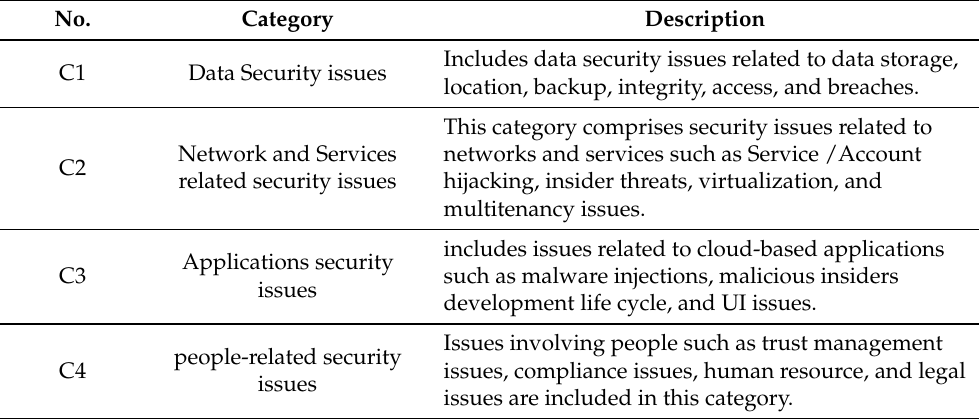
Table 6. Categorization of security issues in cloud